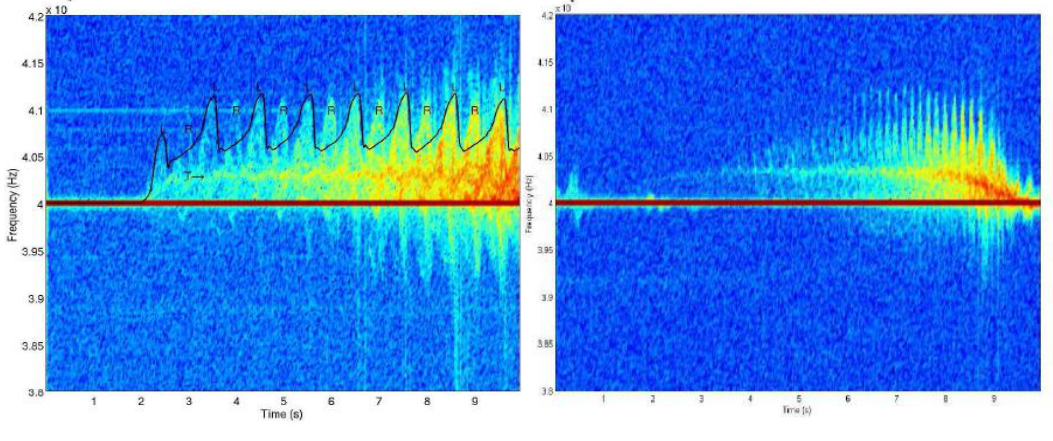
Figure 3. Micro-Doppler gait signature of ( Left ) a person; ( Right ) a dog walking towards an active sensing system. (© 2007 IEEE. Reprinted, with permission,